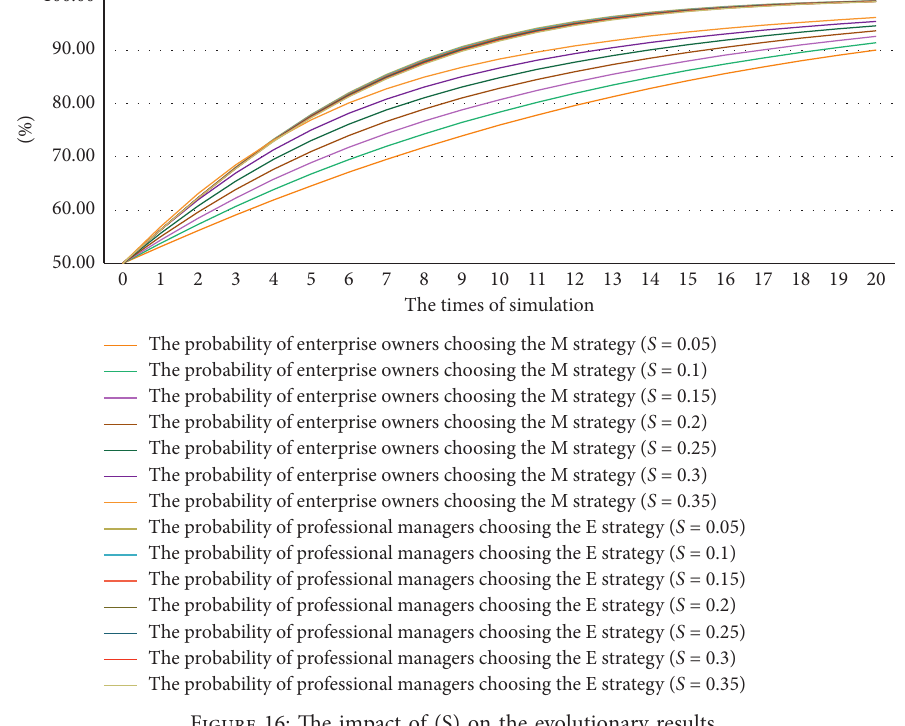
Figure 16: The impact of (S) on the evolutionary